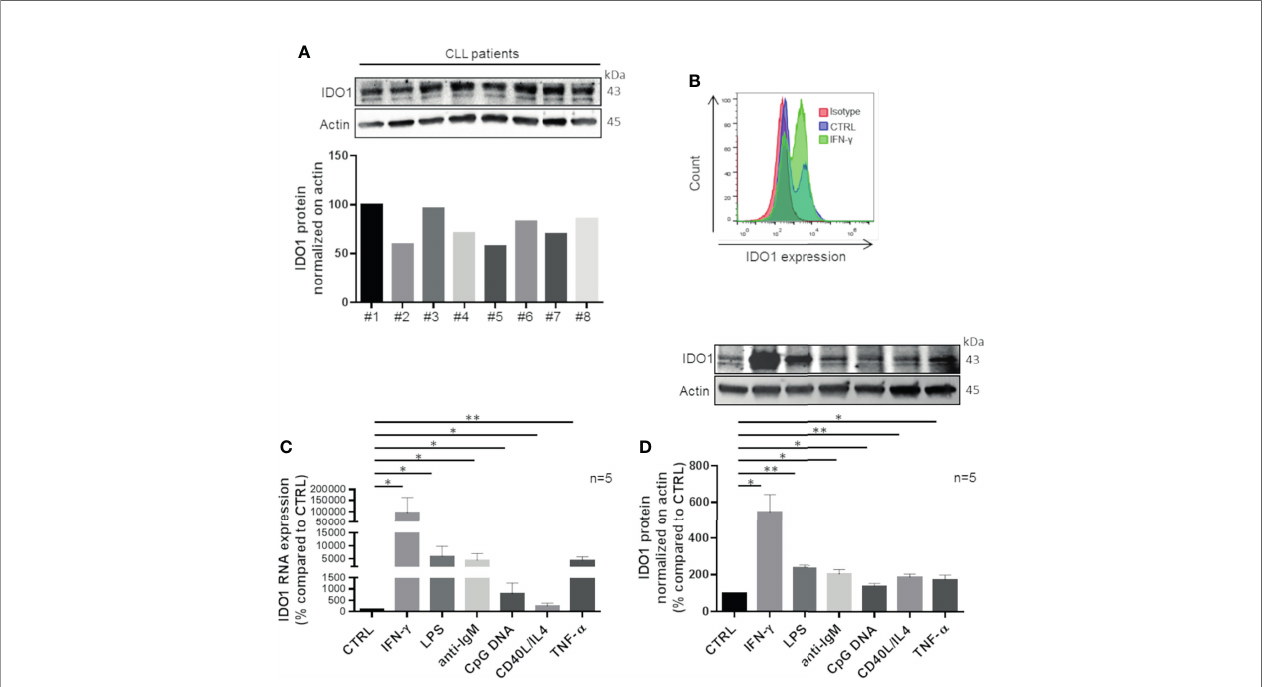
FIGURE 1 | CLL cells up-regulate IDO1 in response to stimuli that mimic microenvironmental signals. (A) Puri fi ed leukemic CD19 + cells from CLL patients were serum starved for 1 h. Then the basal level of IDO1 was inspected by Western blot (n = 8) and illustrated by a bar diagram. (B) Flow cytometric histograms represent a high IDO1 level in CD19 + cells treated for 24 h with IFN- g compared to the untreated control sample and isotype sample. (C) Bar diagram represents IDO1 expression in CD19 + CLL measured by real-time PCR. Samples were treated for 4 h with one of microenvironment stimuli individually (Student paired t test, *p < 0.05, **p < 0.01; n = 5). (D) Immunoblots represent IDO1 protein induction after 24 h of stimulation with the abovementioned factors. Histograms below represent the densitometric quanti fi cations (Student paired t test, *p < 0.05, **p < 0.01; n =